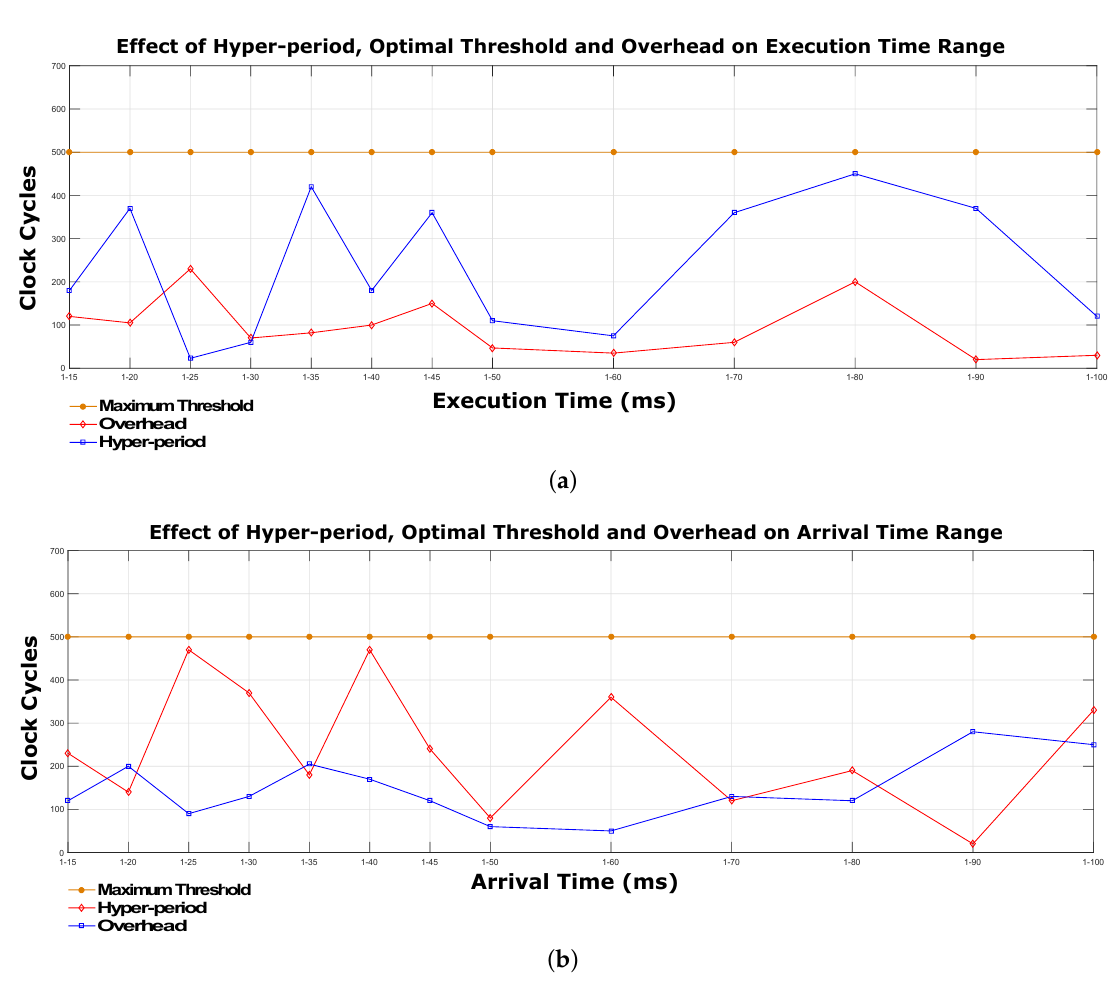
Figure 9. Scenario 3: The effect of varying Execution and Arrival Range, given No. of Tasks = 10, Period Range = 1–10. ( a ) execution time range; ( b ) arrival time